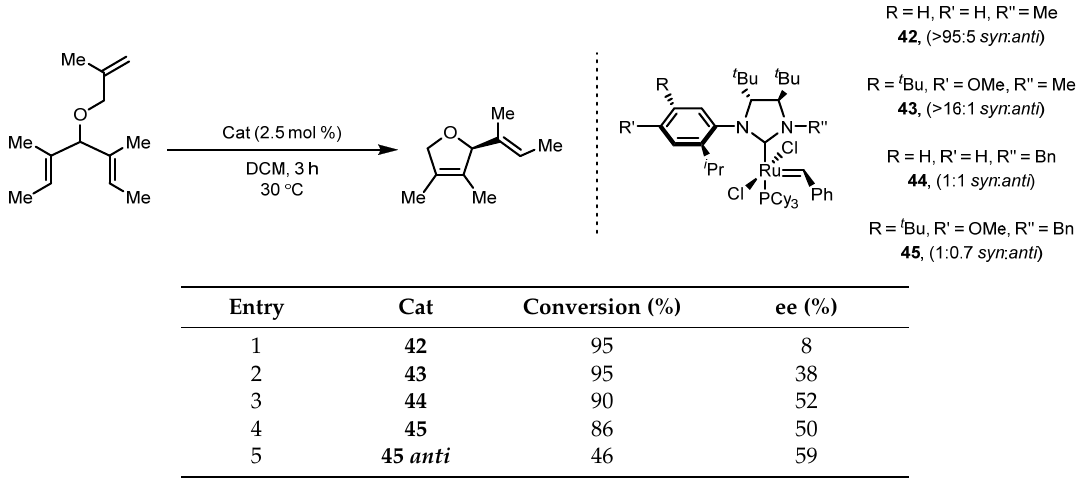
Table 12. Asymmetric ring-closing metathesis (ARCM) to form tetrasubstituted olefins using unsymmetrical N -heterocyclic carbene (NHC) ligands.